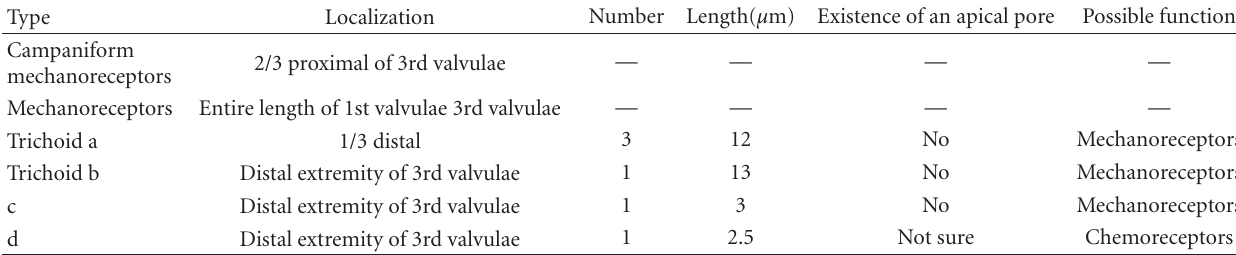
Table 1: Distribution of the sensillae on the ovipositor of P. diplosisae .